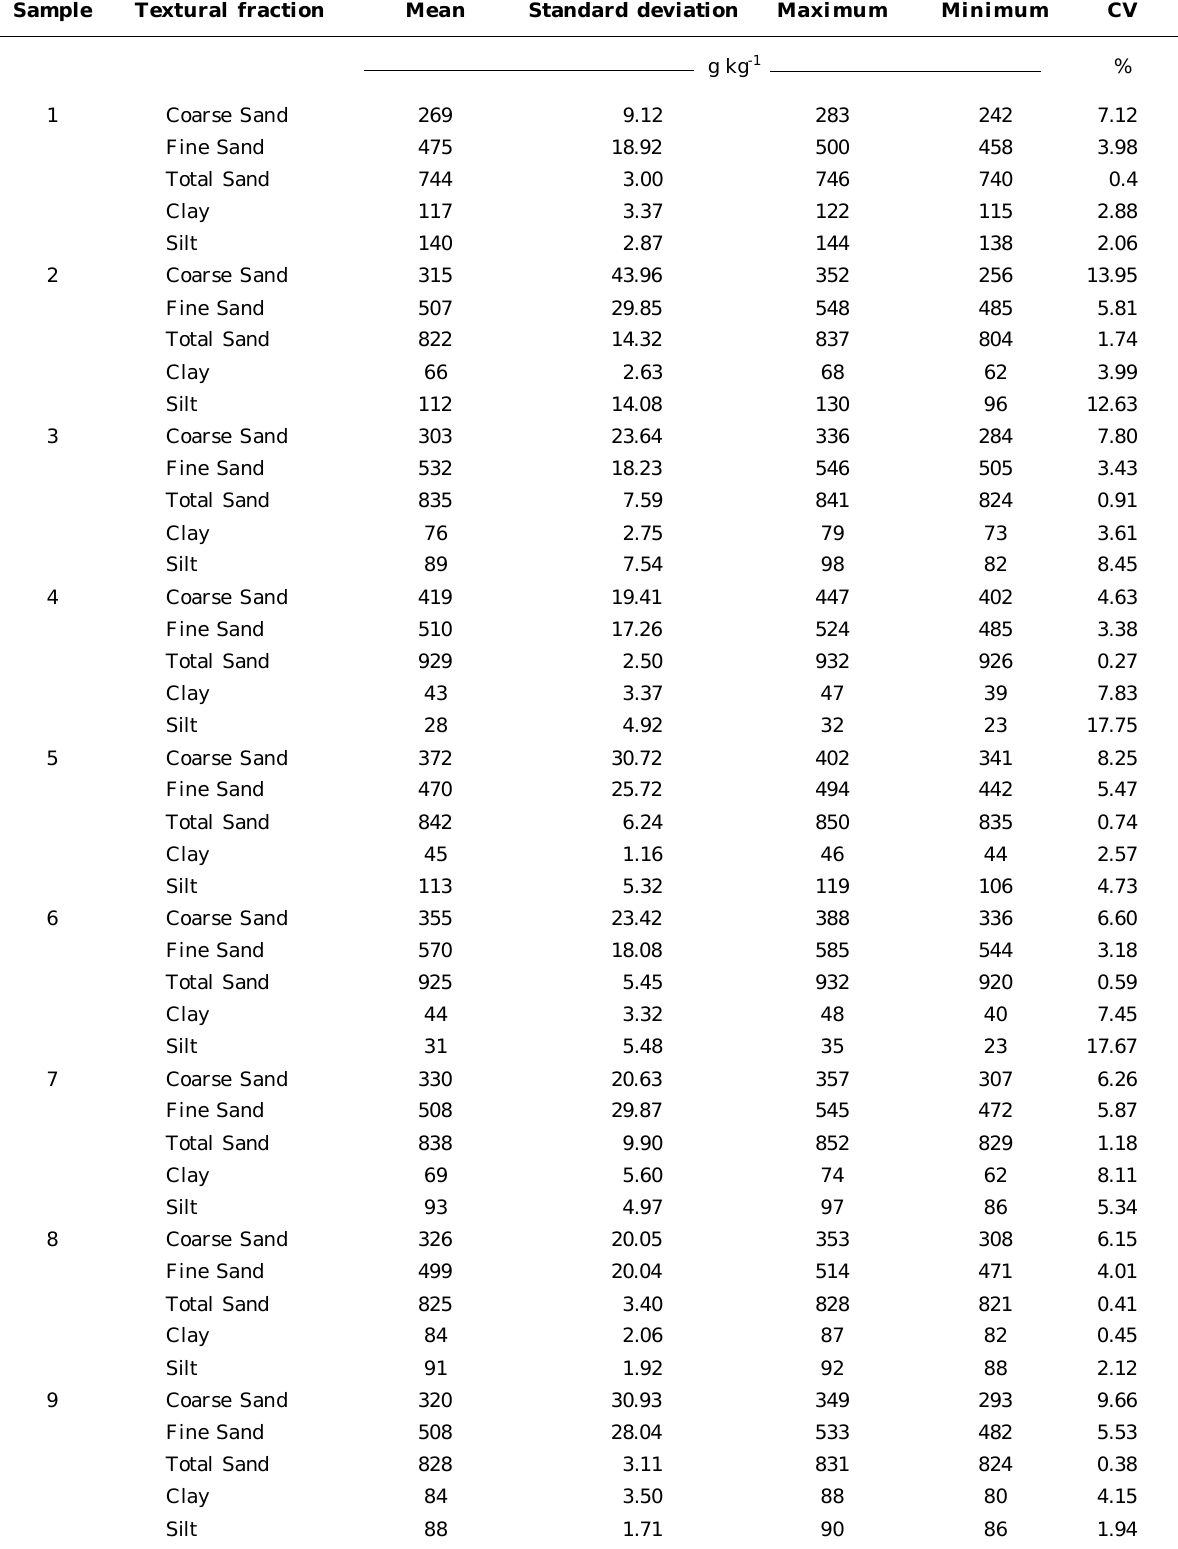
Table 3. Descriptive statistics of the results from particle-size analyses of nine Sandy soil samples (n= 4